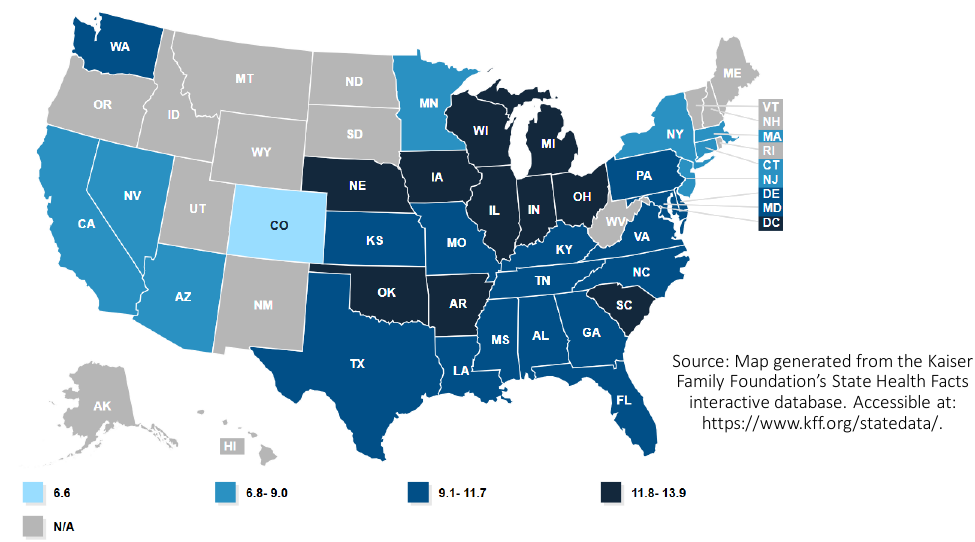
Figure 1. Black infant mortality rate by state (infant deaths per 1000 live births) in the United States in 2018 [15].